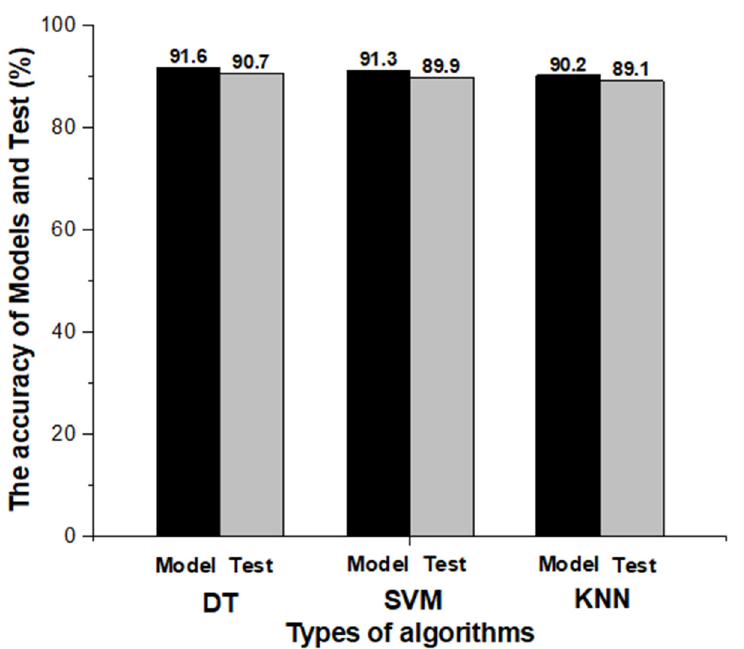
Figure 10. Comparison of the validation accuracy and test accuracy of three classification models used to classify three arm workouts.